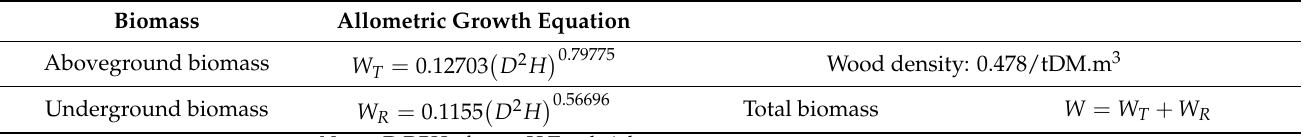
Table 4. Formula of aboveground biomass of cypress allometric growth equation.